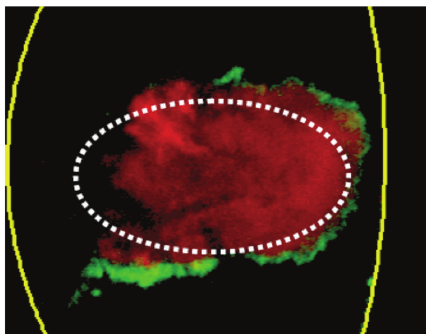
Figure20:OH(green,OH-PLIF)inthinenvelopesurroundingsoot (red, soot LII) throughout the jet cross section